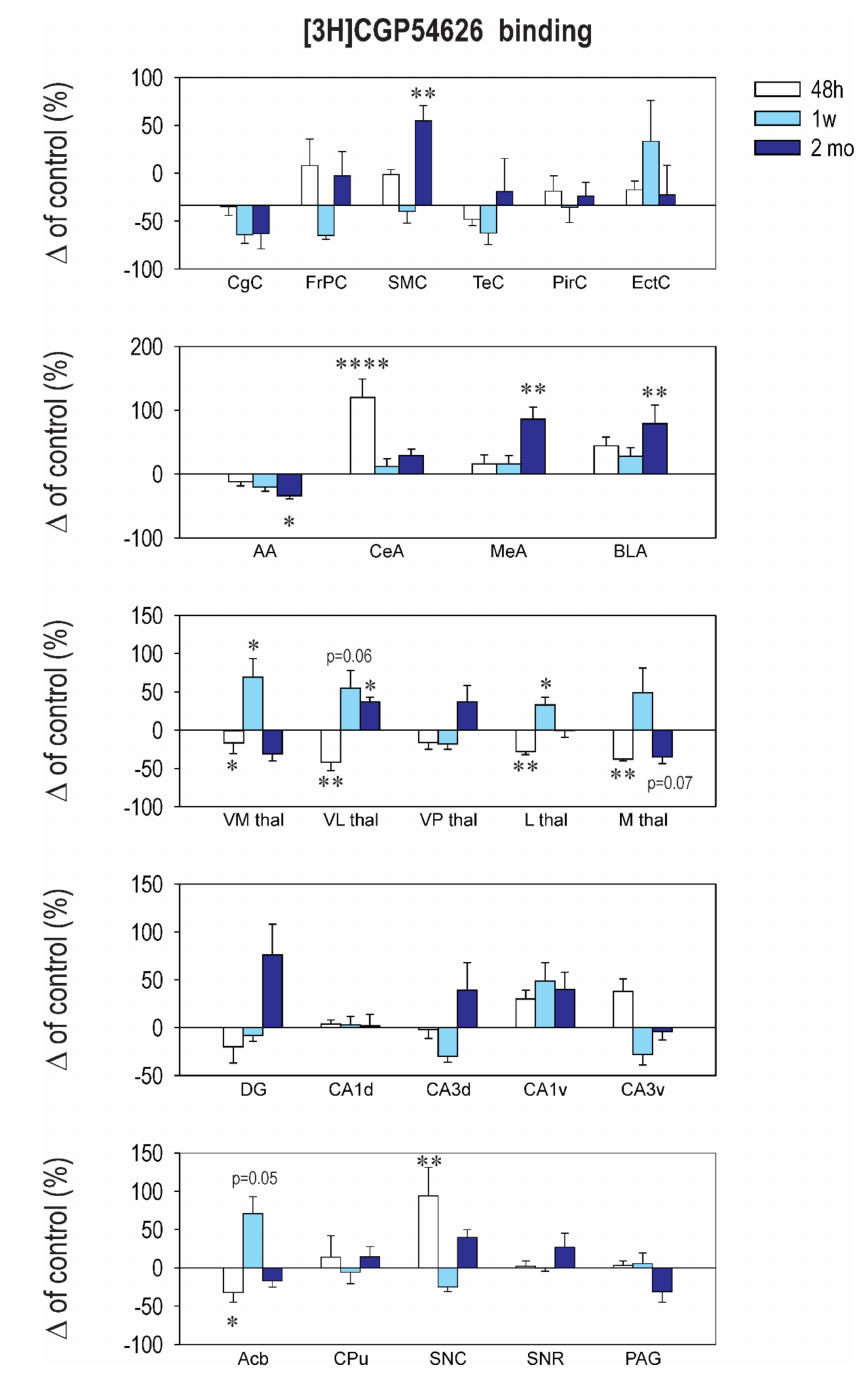
Figure 4. Relative changes in [3H] CGP54626 binding to the GABA B receptors. Details as in Figures 1 and 2. Asterisks denote significant differences from the controls ( * p < 0.05; ** p < 0.01; **** p < 0.0001